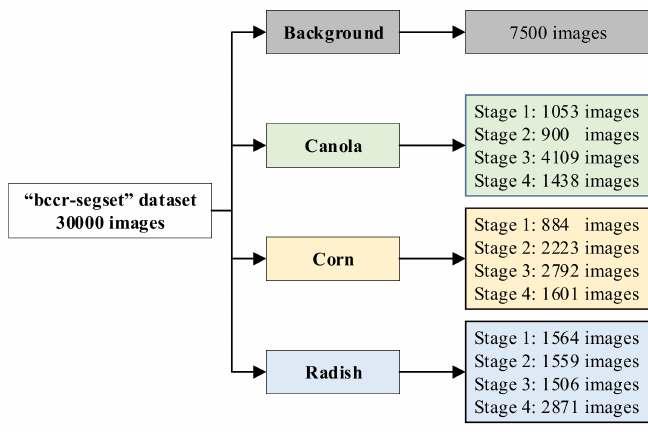
Figure 2. The “bccr-segset” dataset and its four-growth